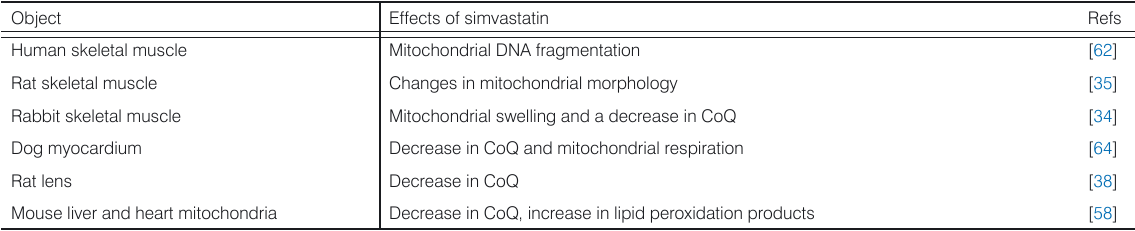
Table 3. Effects of simvastatin on mitochondria in vivo